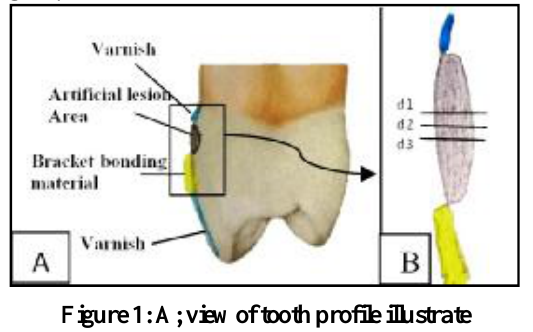
Figure 1: A; view of tooth profile illustrate areas of artificial lesion on buccal surface. B; enlarged artificial lesion demonstrating the three depth measurement at the